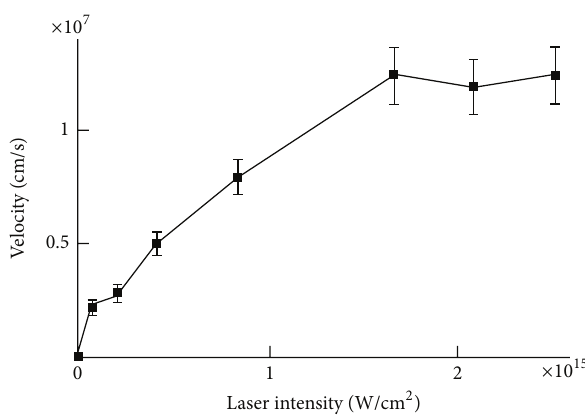
Figure 10: Intensity dependence of the velocity of the plasma front from the Doppler shift of the reflected 700 fs KrF laser pulses from Al target